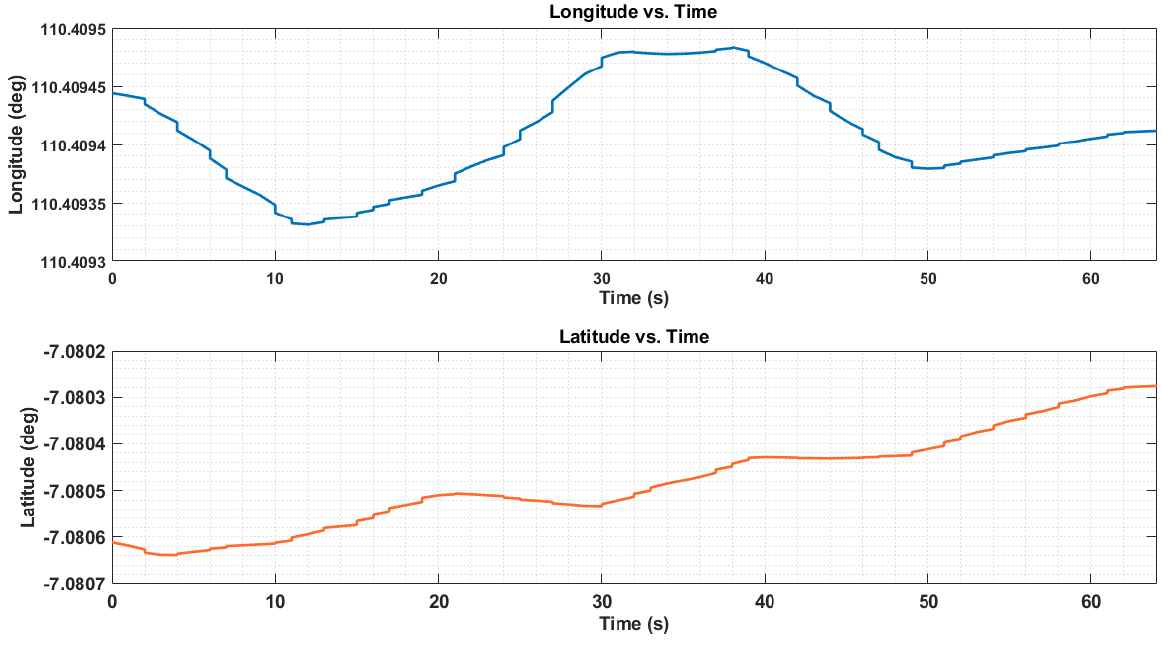
Figure 16. Measured longitude and latitude.